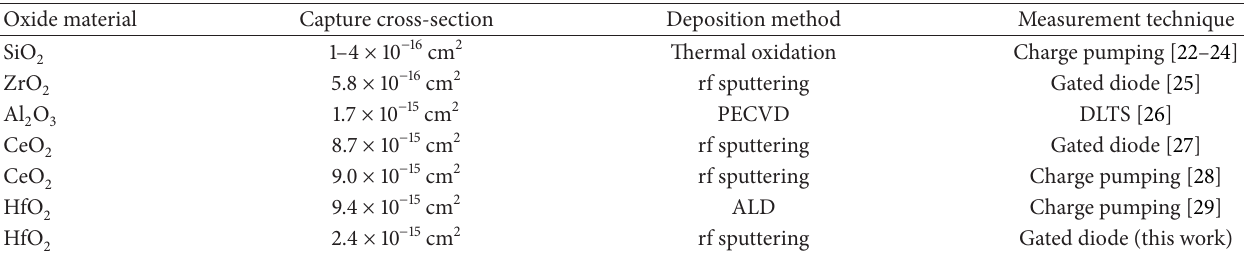
Table 1: Capture cross-section of surface states at the oxide/Si interface.